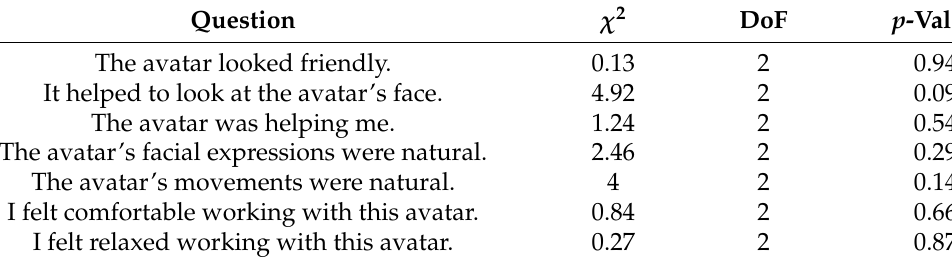
Table 3. Friedman’s test results for individual Likert scale questions.